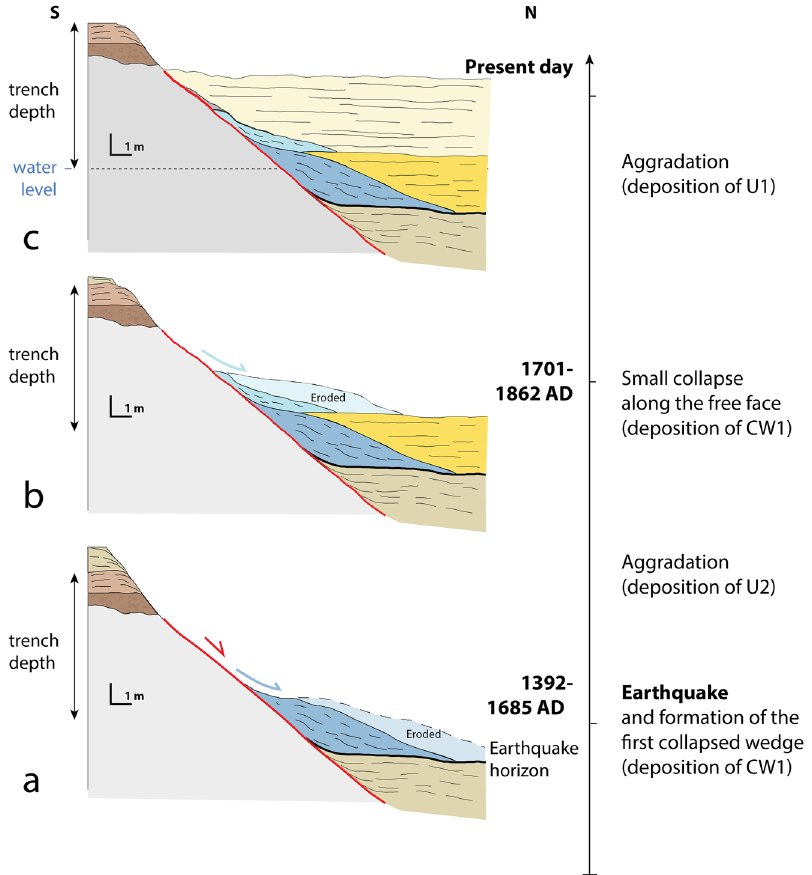
Figure 8. Schematic reconstruction of the Sukhetal site. The details concerning the lithological nature of the units and their colour code are shown Fig. 6. Figure generated with Adobe illustrator CS6 (http:// www. adobe. com/ fr/ produ cts/ illus trator.